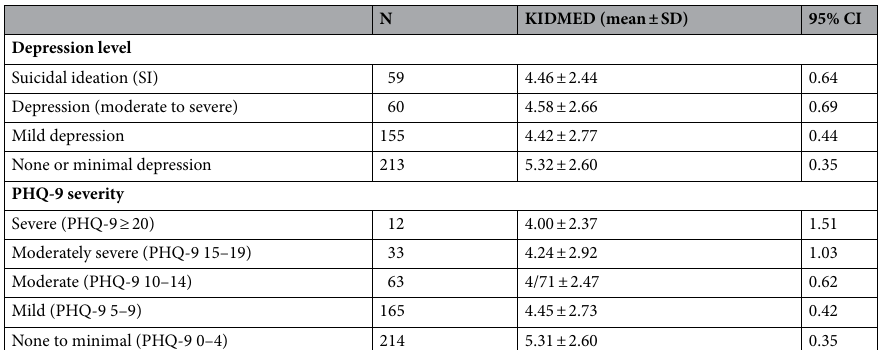
Table 1. Diet and depression distributions in the cohort. Distribution of Patient Health Questionnaire-9 PHQ-9 and KIDMED total scores across 489 subjects: Depression level categories defined as follows: screened positive for recent suicidal ideation (SI) based on a score of ≥ 1 on question 9 of the PHQ-9 (SI), regardless of PHQ-9 score; did not endorse recent SI and had a PHQ-9 total score of 0–4 (None or minimal depression), 5–9 (Mild depression), or ≥ 10 (Depression, moderate to severe). Distribution of PHQ-9 scores is then provided based on the stratification by Kroenke et al.: PHQ-9 total scores, 0–4 (None to minimal), 5–9 (Mild), 10–14 (Moderate), 15–19 (Moderately severe), ≥ 20 (Severe). Two subjects (one with SI and moderate depression and one with NOSI and mild depression) are not presented as their KIDMED had missing values, thus the KIDMED index could not be